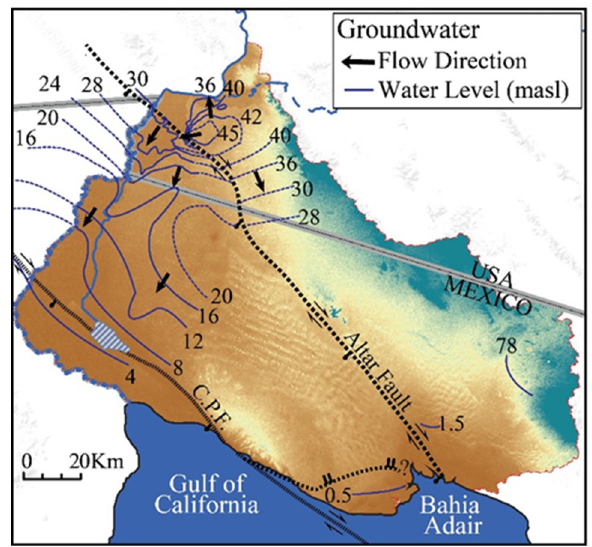
Figure 3. Groundwater levels in 2010. Contours represent water table elevation in meters above sea level (based on data from